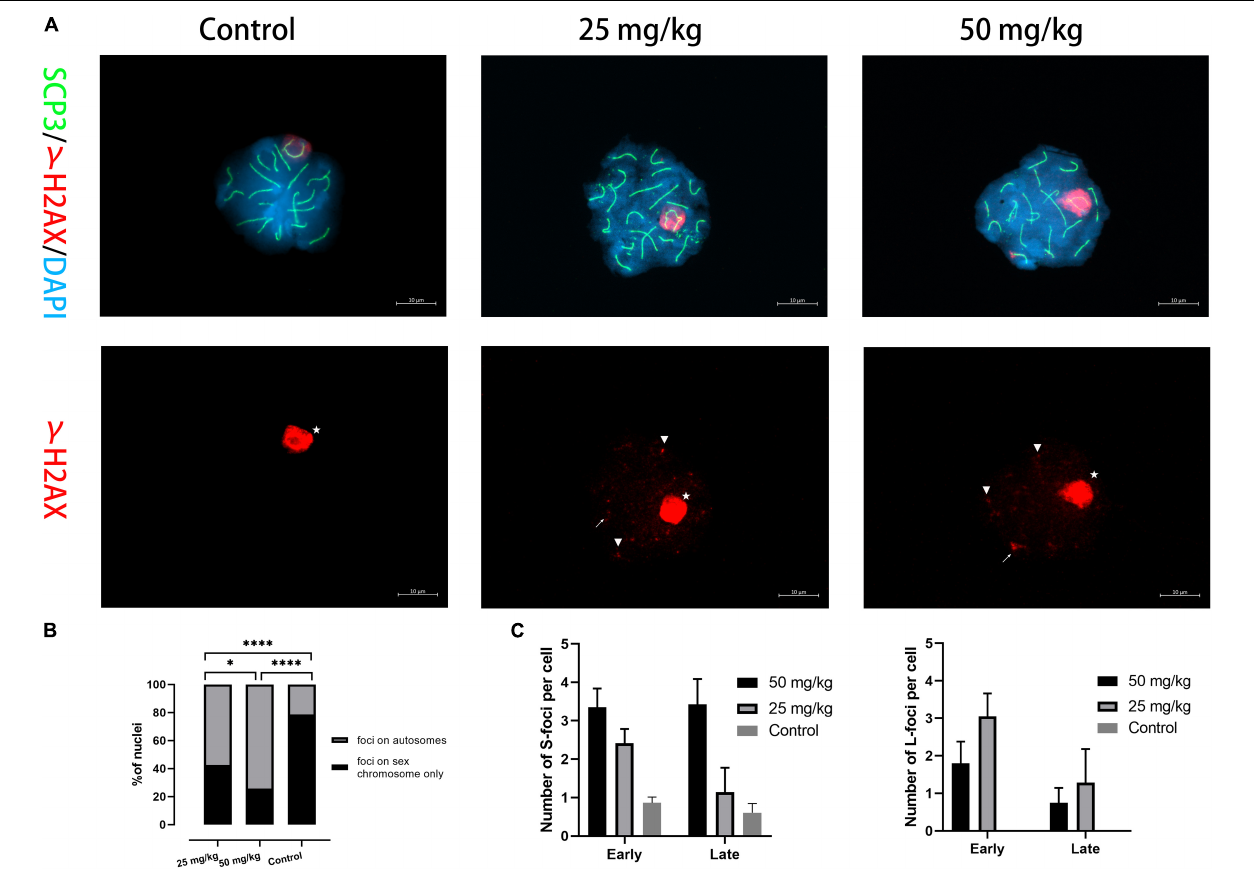
FIGURE 3 | The presence of γ H2AX foci on autosomal SCs. (A) Immunostaining for γ H2AX (red) and SCP3 (green) in mice injected with 25 and 50 mg/kg of HU stained in pachytene spermatocyte chromosome spreads. A single-channel TexRed image for γ H2AX is also presented. Asterisks indicate sex bodies. An arrow indicates L-foci, and arrowheads indicate S-foci associated with axes. Scale bars = 10 µ m. (B) Quantification of the proportions of γ H2AX foci in autosome and sex chromosomes of pachytene nuclei after HU injection; mice injected with 59.2% of 25 mg/kg and 75.7% of 50 mg/kg of HU, compared with 23.1% of controls pachytene nuclei ( n = 70; using the Fisher’s exact test, ∗∗∗∗ p < 0.0001) obtained from five mice of each group showed spermatocytes with γ H2AX foci. (C) Quantification of γ H2AX foci containing S-foci and L-foci in early and late pachytene cells of mice injected with 25 and 50 mg/kg of HU (i.e., black and gray bars, respectively) showed spermatocytes with γ H2AX foci. Bars represent mean ± SEM. The statistical analysis between mice injected with 25 and 50 mg/kg of HU at early and late pachytene ( n = 70) was performed using the Mann–Whitney U -test, and ns indicates no significant difference between the two doses of HU injection ( p > 0.05). * p <